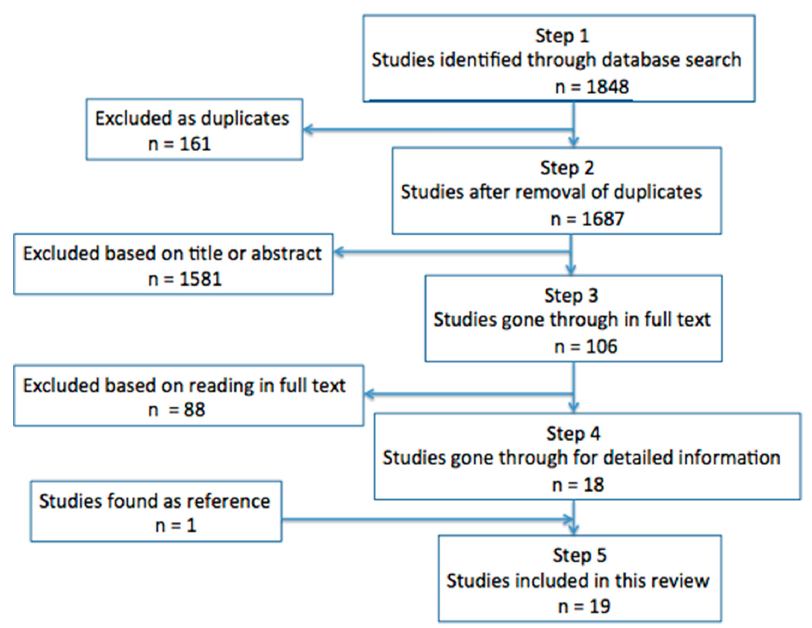
Figure 1. Identification of the included studies. “n” is a combined number of studies identified through both the initial and the updated